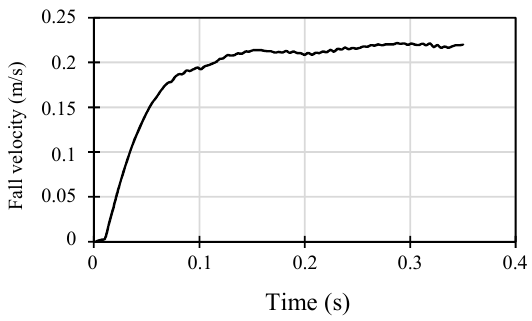
Fig. 7. Particle velocity versus time in particle with diameter of 2.18 mm